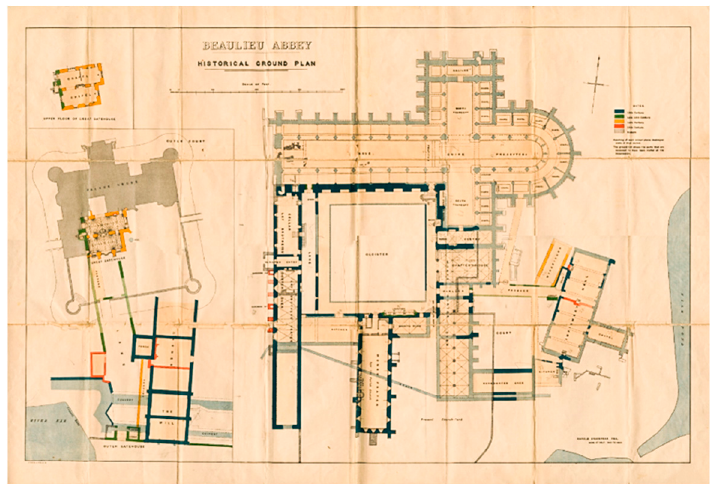
Figure 2. Beaulieu Abbey floor-plan [8].